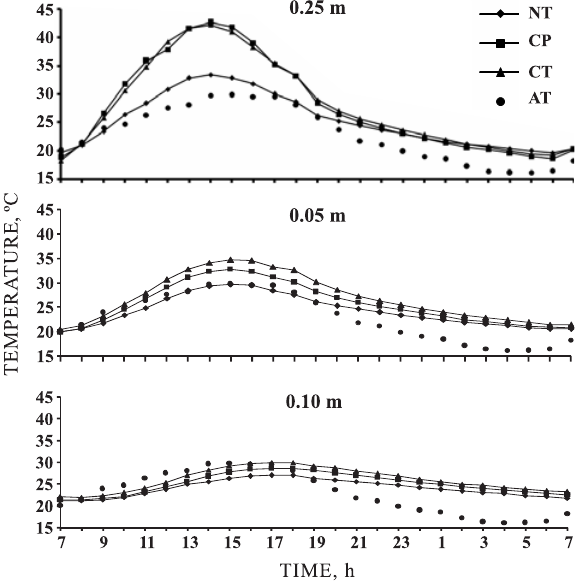
Figure 3. Air and soil temperatures at 0.025, 0.05 and 0.10 m depths over 24 h (12 days after sowing) in three soil tillage systems. (NT: no-tillage; CP: chisel plow; CT: conventional tillage; AT: air